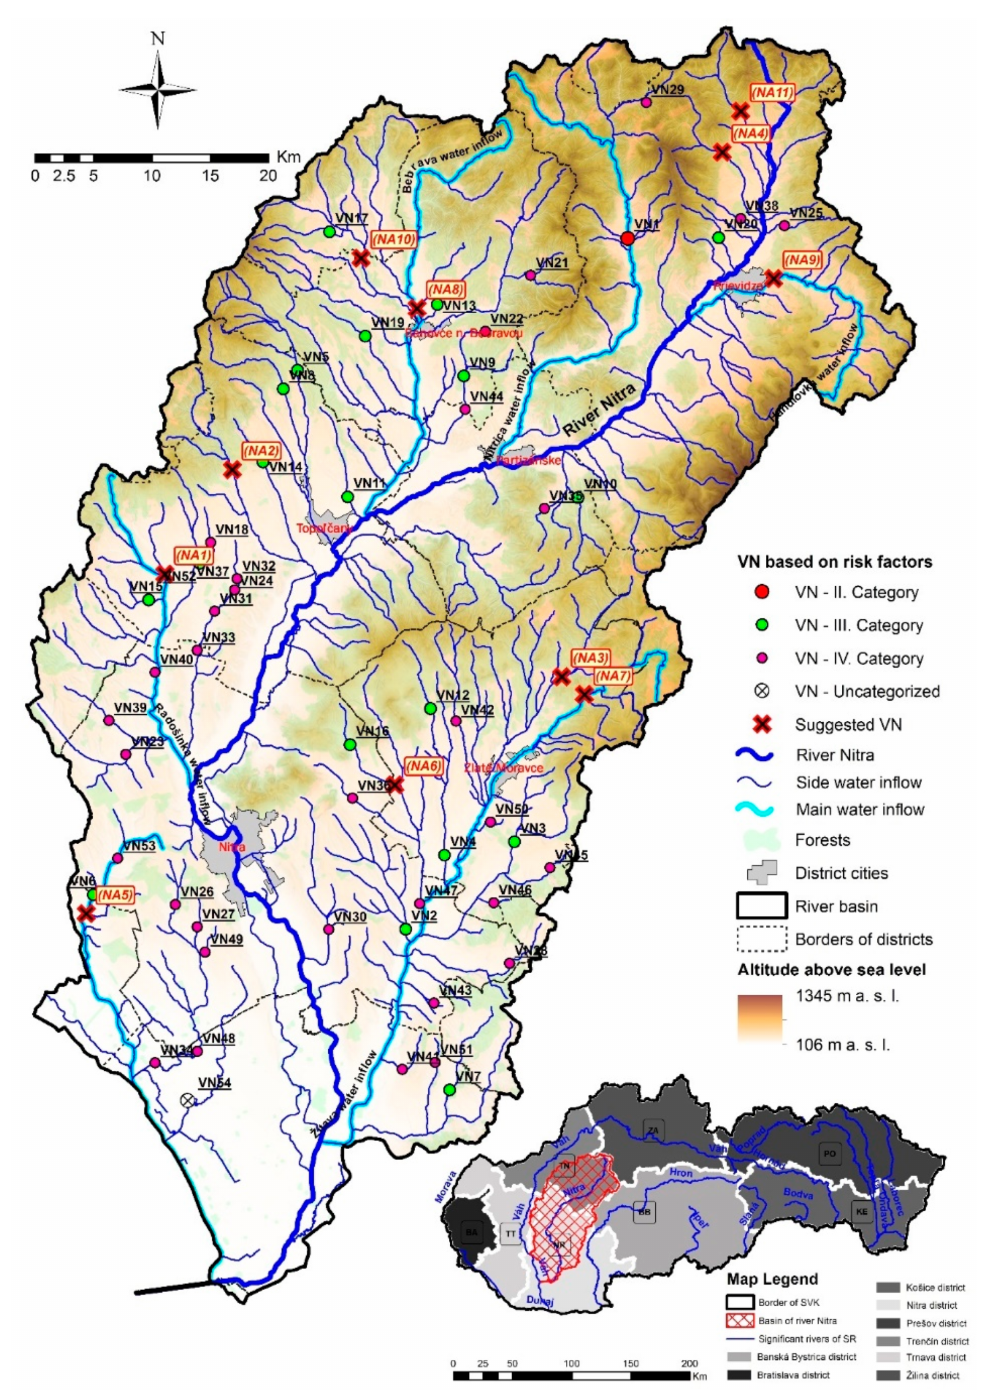
Figure 1. Division of reservoirs in Nitra river basin by risk